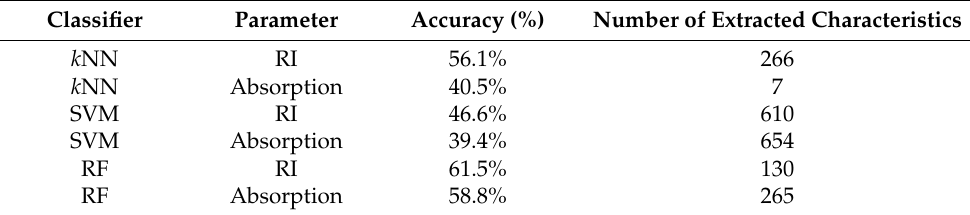
Table 2. Classification accuracy of the three types of classifiers for the five clinical